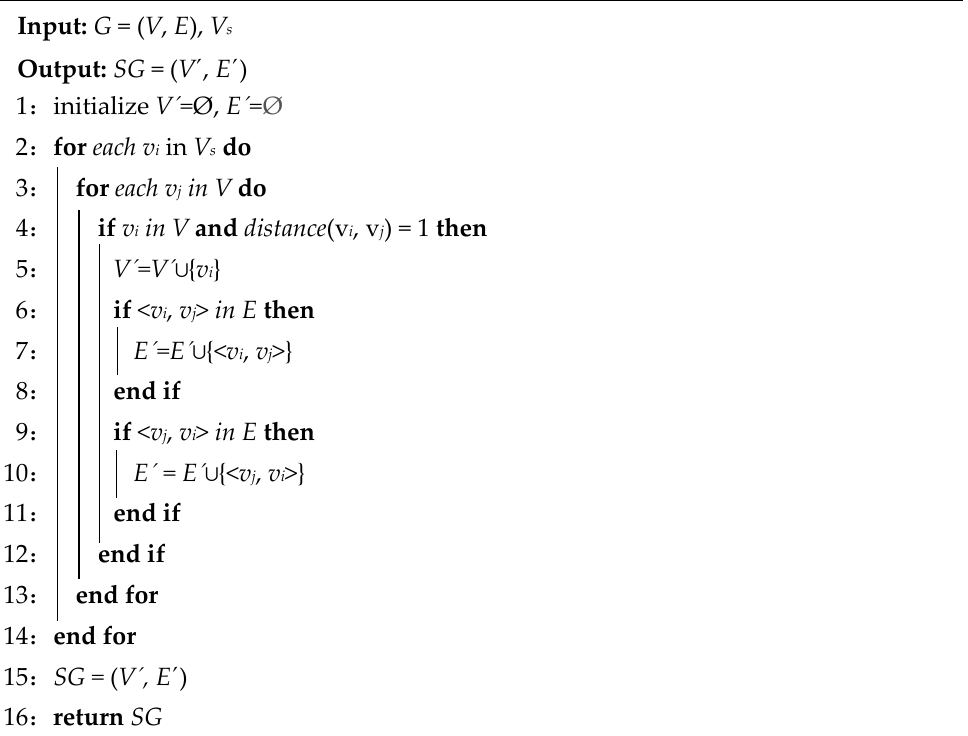
Algorithm 1 Generating the subgraph of sensitive API calls